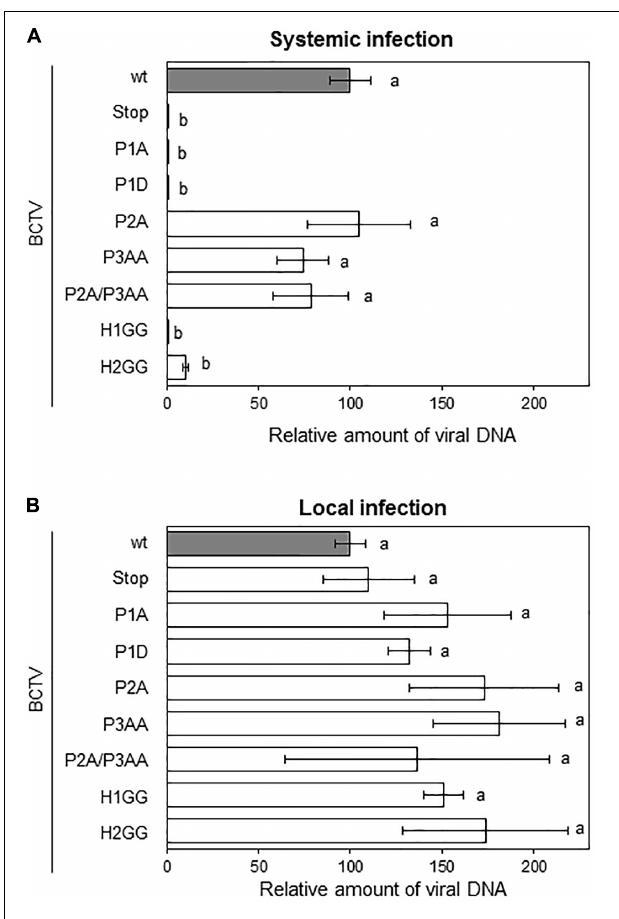
FIGURE 6 | Infection of N. benthamiana plants with BCTV V2 mutants. Plants were agroinoculated with wild-type or V2 mutated BCTV infective clones. Relative viral DNA accumulation in apical leaves (systemic infection) at 28 dpi (A) or at the infiltrated leaves (local infection) at 4 dpi (B) . BCTV accumulation was measured by qPCR. DNA levels were normalized to 25S ribosomal DNA interspacer (ITS) and are presented as the relative amount of virus compared with the amount found in wild-type BCTV (wt) samples (in gray, set to 100%). Bars represent mean values ± standard error (SE) for 4–8 pools of two leaves from 3 to 4 plants each one. Mean values marked with different letter (a or b) indicate results significantly different from each other, as established by One Way ANOVA (Dunnett’s Multiple Comparison Test; P <